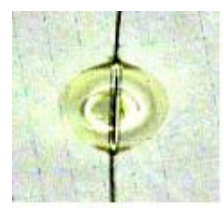
Figure 12. Specimen of the stainless-steel fiber with the epoxy resin microdroplet.